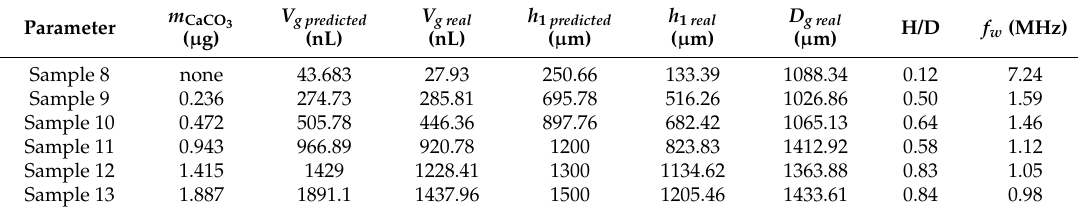
Parameter Table 4. The experimental results of the glass shell samples blown by 200 µ m deep etched cavities 1 .